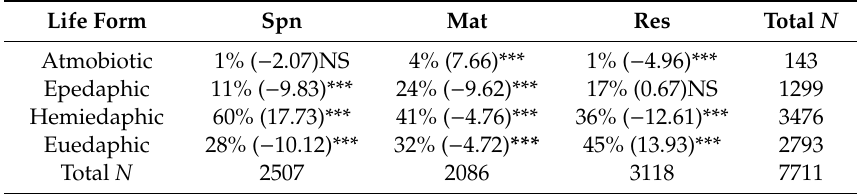
Table 2. Life-form structure of collembolan assemblages in spontaneously developed stands (Spn), mature stands in managed forests (Mat), and old-growth stands in Strict Reserve (Res) with results of pairwise comparisons (post hoc test after χ 2 test). Residual values in brackets. Percentages are presented for readability. Total N—number of